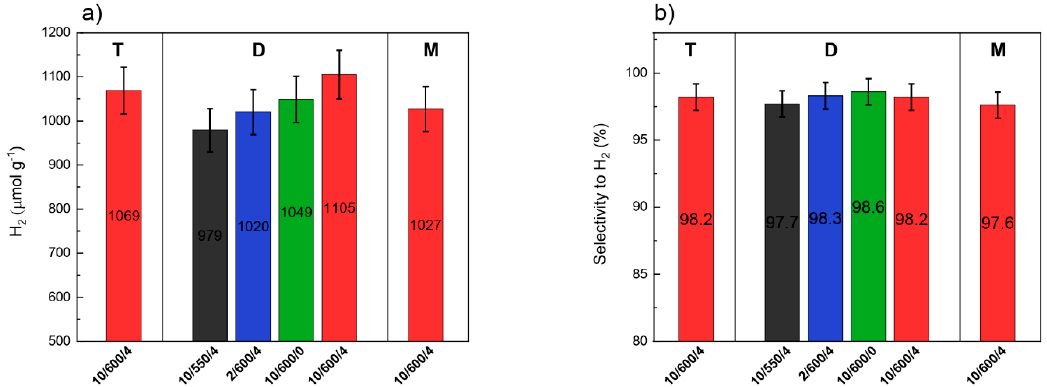
Figure 12. Photocatalytic activity of di ff erent carbon nitrides in the photocatalytic decomposition of water-methanol solution ( a ) and selectivity to hydrogen ( b ) after 4 h